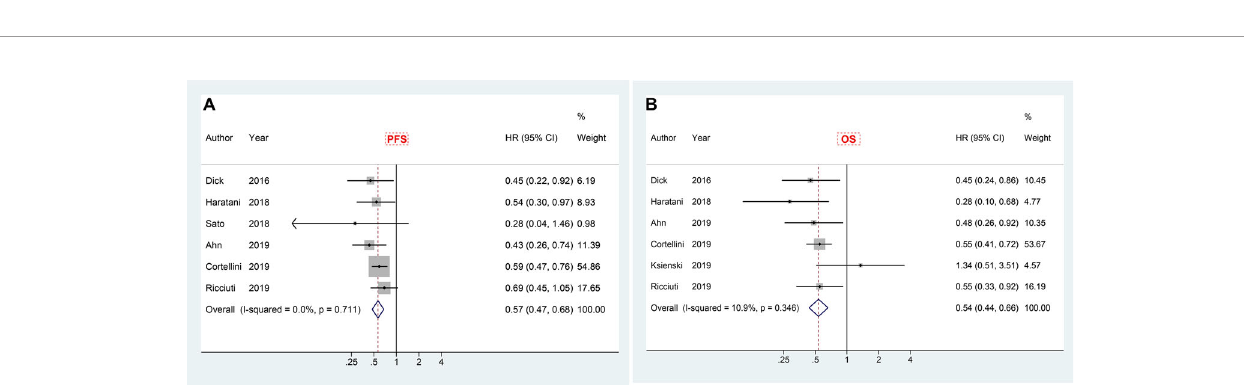
FIGURE 5 | Forest plot of landmark analysis in exploring the associations of immune-related adverse events with PFS (A) and OS (B) in cancer patients receiving immune checkpoint inhibitors. HR, hazard ratio; CI, con fi dence interval; PFS, progression free survival; OS, overall